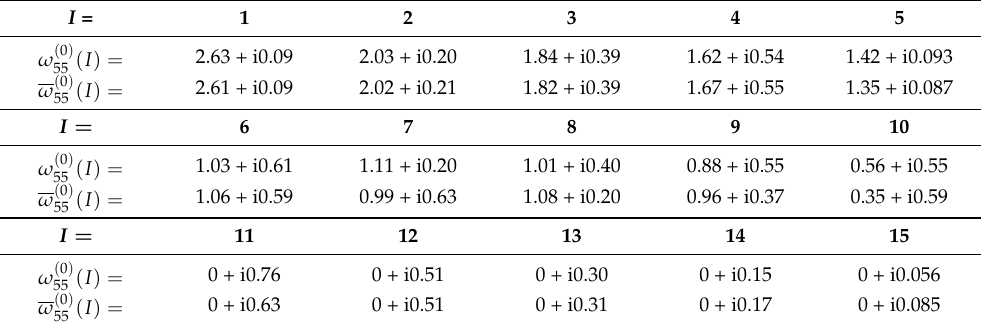
Table 2. For the case L = N = 5, m = 0 and E = 0.01: Values for the eigenfrequencies ω ( 0 ) ( I ) for I = 1, . . . ,15. The index I = 1 to 15 is ordered to correspond to the largest values of | ω ( 0 ) ω 55 ( 0 ) | to their smallest values. We define ω ( 0 ) or | ω 55 I = 16, . . .